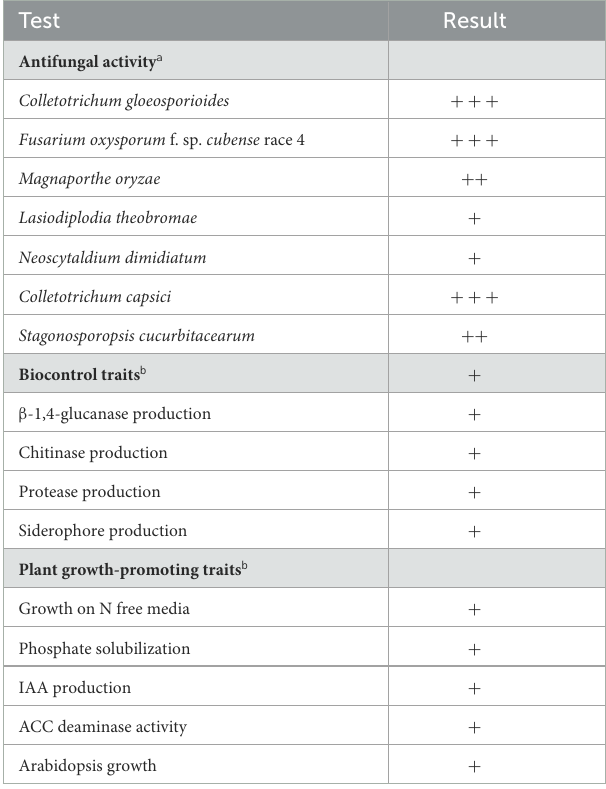
TABLE 1 Traits of biocontrol and PGP of strain HNM0140 T